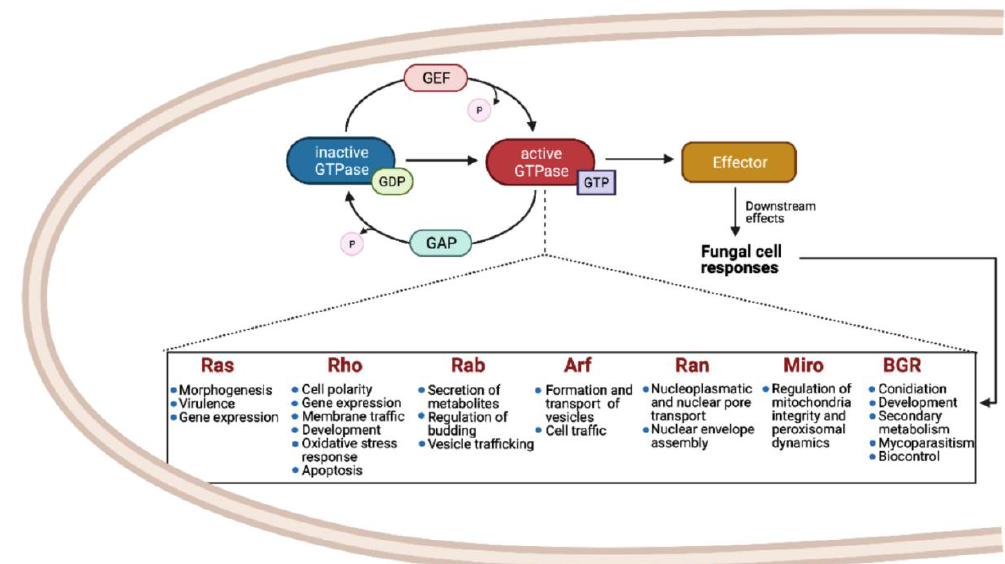
Figure 1. Small GTPases of the Ras superfamily regulate several processes in fungi. In fungal cells, GEFs and GAPs catalyze alternation between an active GTP-bound state and an inactive GDP-bound state. Active GTPase interacts with specific downstream effector, leading to different cell responses. The most representative functions of Ras GTPase families are listed in the box.